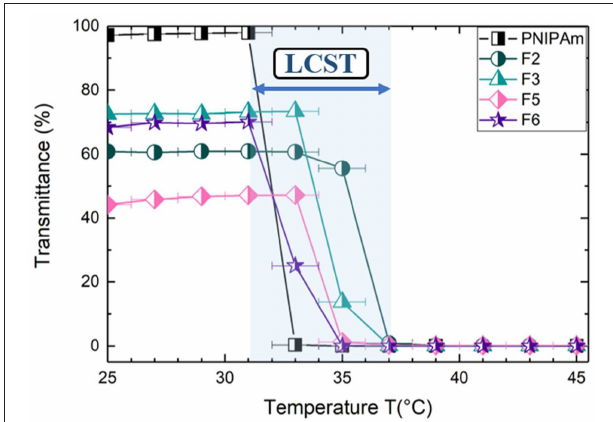
FIGURE 4 | Transmitance variation as a temperature function. LCST identification.